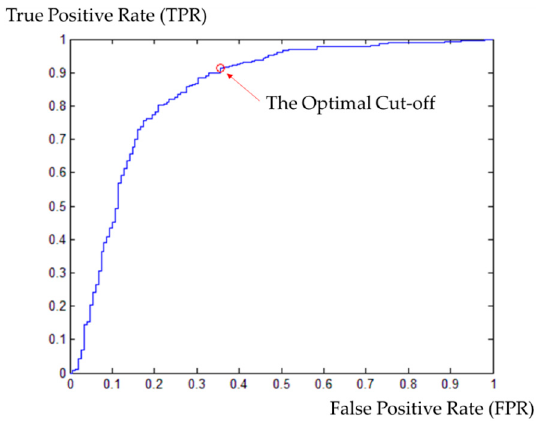
Figure 12. The ROC curve from the training dataset for the Fréchet-distance-based method. The relationship between TPR and FPR is depicted and the optimal cutoff on the curve is determined to be the point (0.3557, 0.9140).